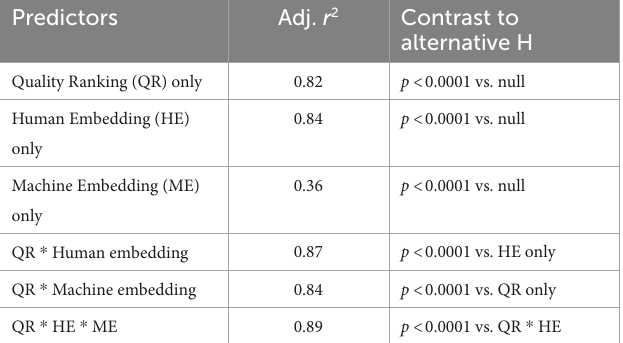
TABLE 2 Adjusted r 2 and model-comparison p values for regressions predicting a drawing’s checklist score from the new metrics. Predictors Adj. r